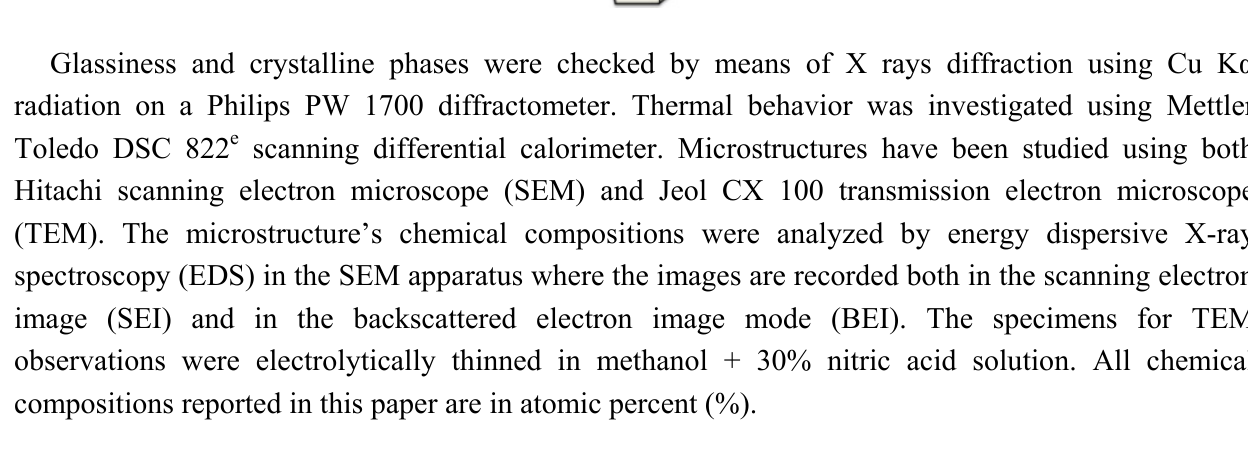
Figure 17. Sketch of the processed wedged